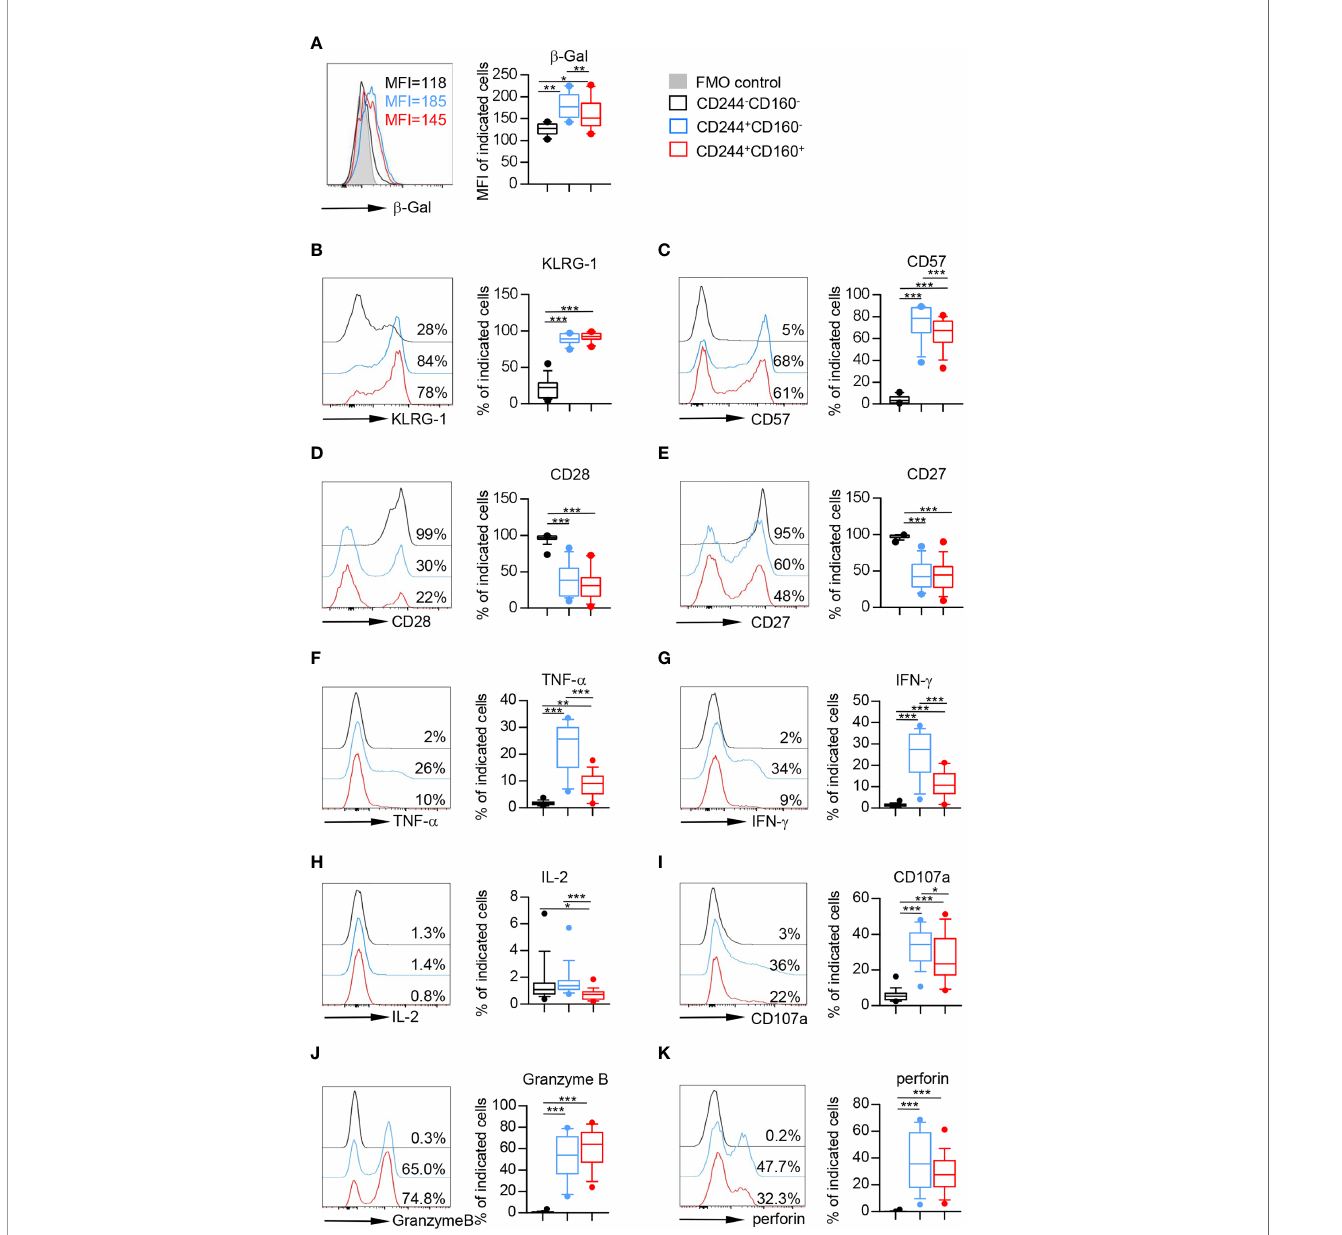
FIGURE 3 | Flow cytometry analysis of senescent features on CD244 - CD160 - , CD244 + CD160 - and CD244 + CD160 + CD8 + T cells from the elderly. Flow cytometry analysis of senescence-associated markers on CD244 - CD160 - , CD244 + CD160 - and CD244 - CD160 + CD8 + T-cell subsets. (A) Representative histograms (left) and box plots (right) display the b -Gal activity measured by the mean fl uorescence intensity (MFI) on CD244 - CD160 - , CD244 + CD160 - and CD244 + CD160 + CD8 + T cells (n = 10). P values were obtained by repeated-measures ANOVA followed by Tukey ’ s multiple comparisons test. (B – E) Representative histograms (left) and box plots (right) display the expression of KLRG-1 (B) , CD57 (C) , CD28 (D) , and CD27 (E) on CD244 - CD160 - , CD244 + CD160 - and CD244 + CD160 + CD8 + T cells from the elderly (61-90 years old, n = 15-17). P values were obtained by repeated-measures ANOVA followed by Tukey ’ s multiple comparisons test (KLRG-1, CD57, and CD27) or Friedman ’ s test followed by Dunn ’ s multiple comparisons test (CD28). (F – H) Intracellular staining for TNF- a , IFN- g , and IL-2 on CD244 - CD160 - , CD244 + CD160 - and CD244 - CD160 + cells (gated with CD8 + T cells) from the elderly (61-90 years old, n = 17) after in vitro anti-CD3/anti-CD28 stimulation. Representative histograms (left) and box plots (right) for TNF- a (F) , INF- g (G) , and IL-2 (H) , respectively. P values were obtained by repeated-measures ANOVA followed by Tukey ’ s multiple comparisons test (TNF- a and INF- g ) or Friedman ’ s test followed by Dunn ’ s multiple comparisons test (IL-2). (I – K) Expression of CD107a, Granzyme B, and perforin on CD244 - CD160 - , CD244 + CD160 - and CD244 + CD160 + CD8 + T cells from the elderly (61-90 years old, n = 17). Representative histograms (left) and box plots (right) of CD107a (I) , Granzyme B (J) , and perforin (K) expression. P values were obtained by repeated-measures ANOVA followed by Tukey ’ s multiple comparisons test (CD107a) or Friedman ’ s test followed by Dunn ’ s multiple comparisons test (Granzyme B and perforin). * P < 0.05, ** P < 0.01, *** P <